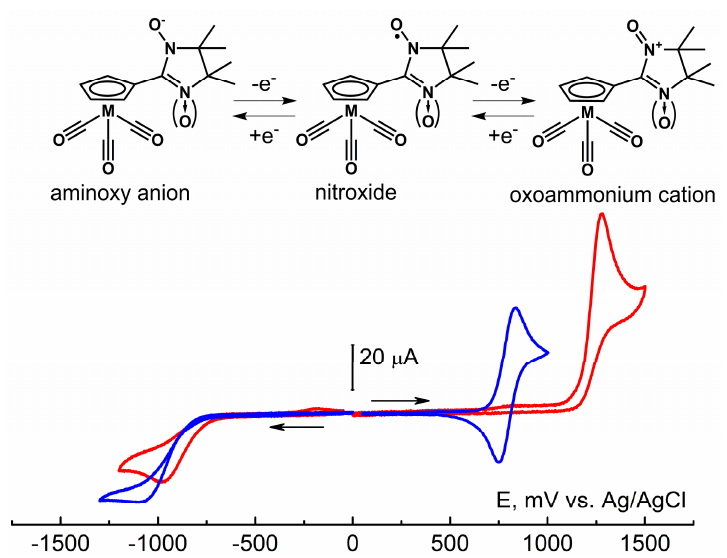
Figure 3. Redox processes of the NNMn/INMn molecules and CV curves of oxidation and reduction in NNMn (blue line) and INMn (red line) 5.0 × 10 − 3 M solutions in MeCN (a GC disk electrode d = 1.7 mm, supporting electrolyte 0.1 M Bu 4 NBF 4 /MeCN, the scan rate 100 mV s − 1 , T = 298 K).